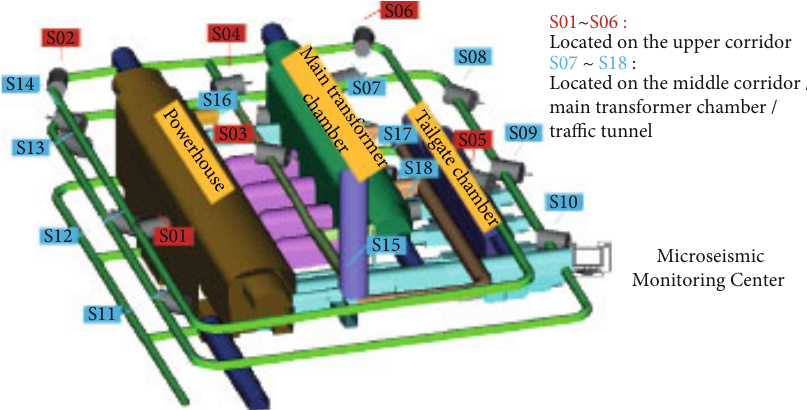
Figure 6: Schematic diagram of sensor layout in underground powerhouse area.